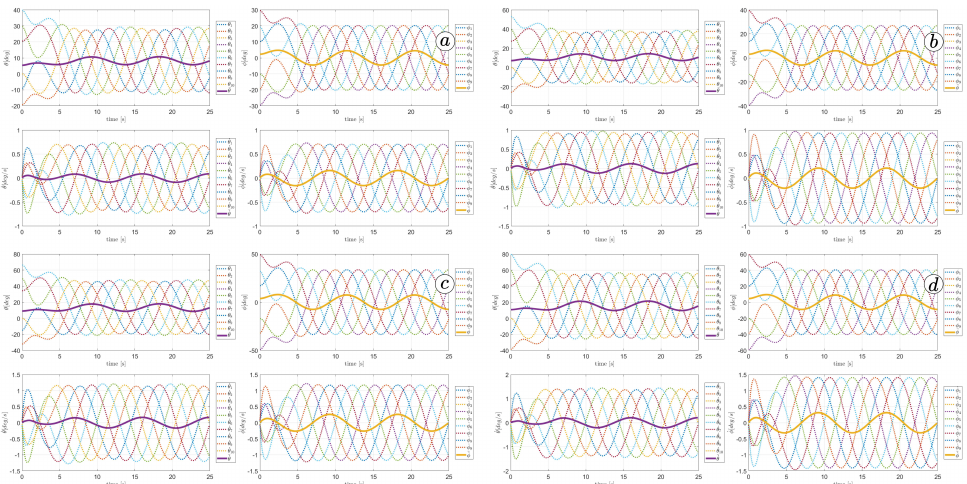
Figure 25. Values of link angles θ , joint angles φ , link angles derivatives ˙ θ , joint angles derivatives ˙ φ for α = 30 ◦ ( a ), α = 40 ◦ ( b ), α = 50 ◦ ( c ), and α = 60 ◦ ( d ).